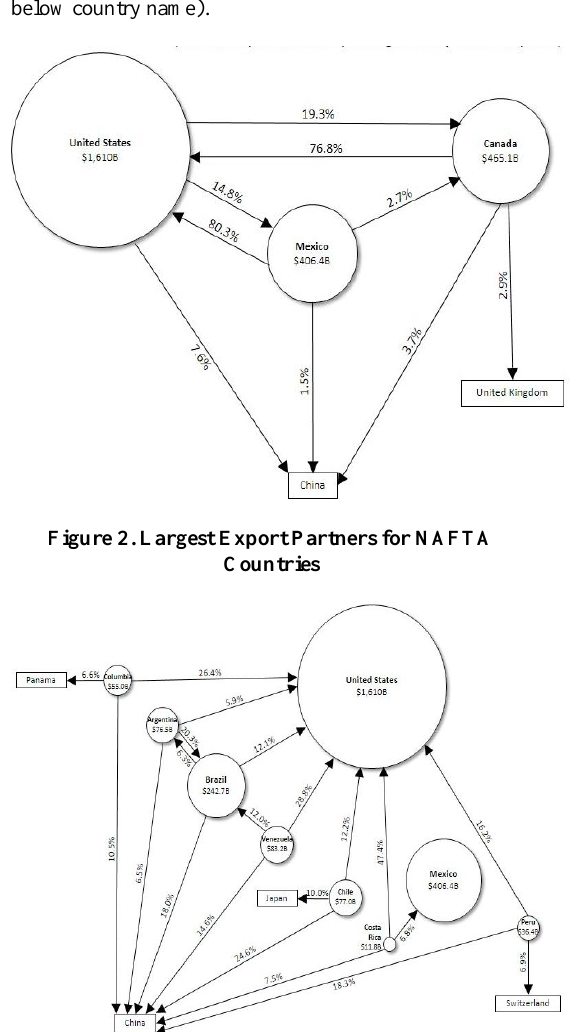
Figure 3. Largest Export Partners for Latin American Countries